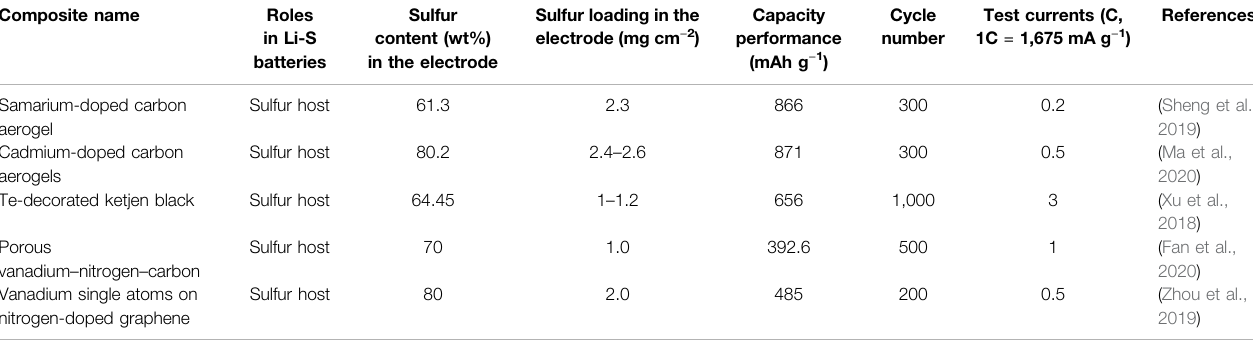
TABLE 3 | Other transition metal atom-decorated carbon materials for enhancing the performances of Li-S